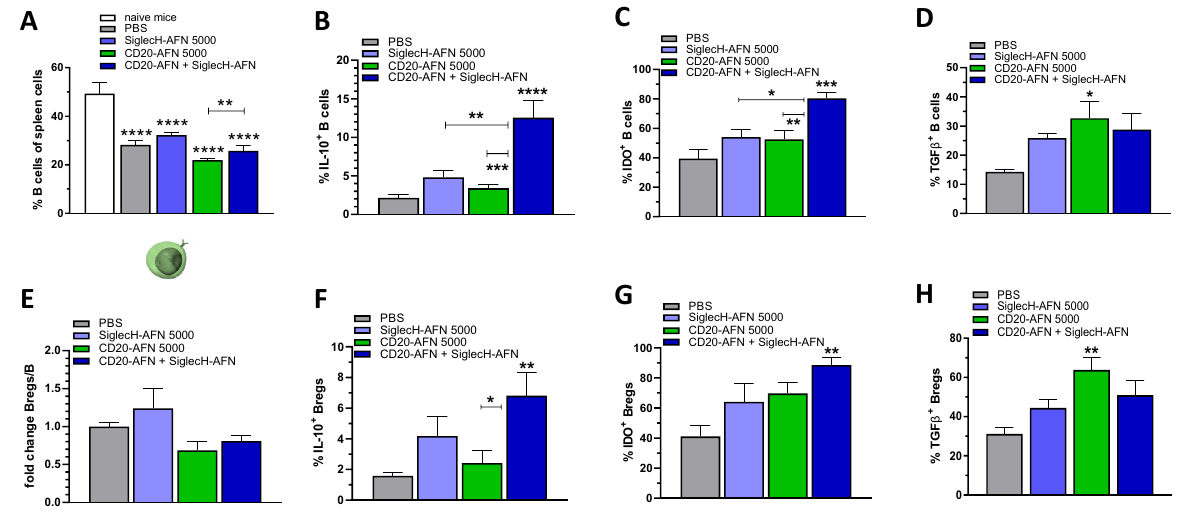
Figure 4. Superior protective combination therapy correlates with IL-10 and IDO expression in B cells. Amounts of splenic B cells were decreased on d15 due to EAE, AFN treatments did not affect that ( A ). IL-10 and IDO expression were dramatically increased if EAE mice were treated with the combination therapy ( B , C ). TGFβ was also increased, but only significantly by CD20-AFN monotherapy. Similar results were found in CD5 + CD1d + Bregs, whose numbers were not affected by AFN therapies ( E – H ). Shown are 2 pooled experiments (n = 7). Differences were assessed using one-way ANOVA followed by Tukey’s multiple-comparison test; *P < 0.05, **P < 0.01, ***P < 0.001, ****P < 0.0001 compared with PBS treated animals, unless otherwise